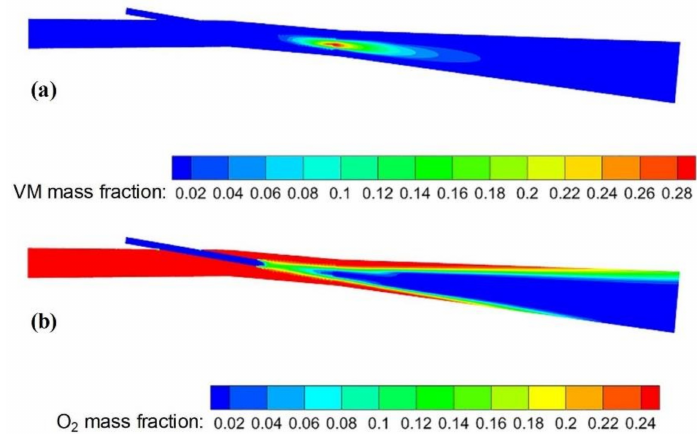
Figure 7. Mass fraction distributions of the VM ( a ) and O 2 ( b